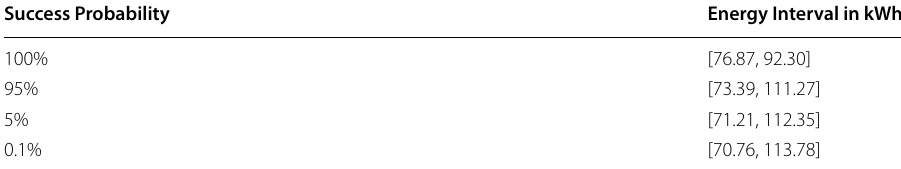
Table 6 Different intervals of Probabilistic FlexOffers success for assigned thermal energy